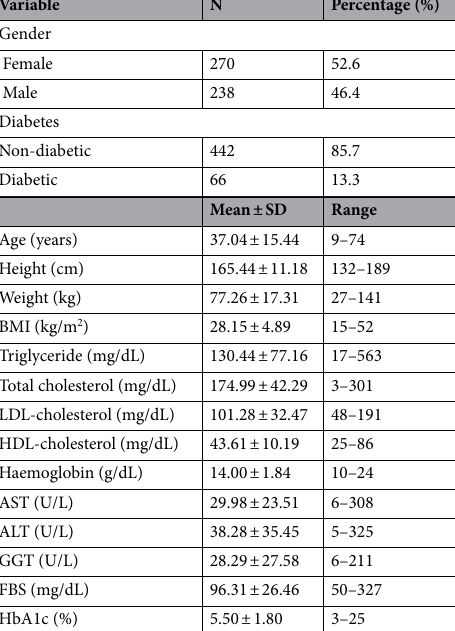
Table 1. Demographic information of study participants. SD standard deviation, cm centimetres, kg kilograms, BMI body mass index, kg/m 2 kilograms per metres squared, mg/dL milligrams per decilitre, g/ dL grams per decilitre, U/L units per litre, AST aspartate aminotransferase, ALT alanine transaminase, GGT gamma-glutamyl transferase, FBS fasting blood glucose, HbA1c glycosylated